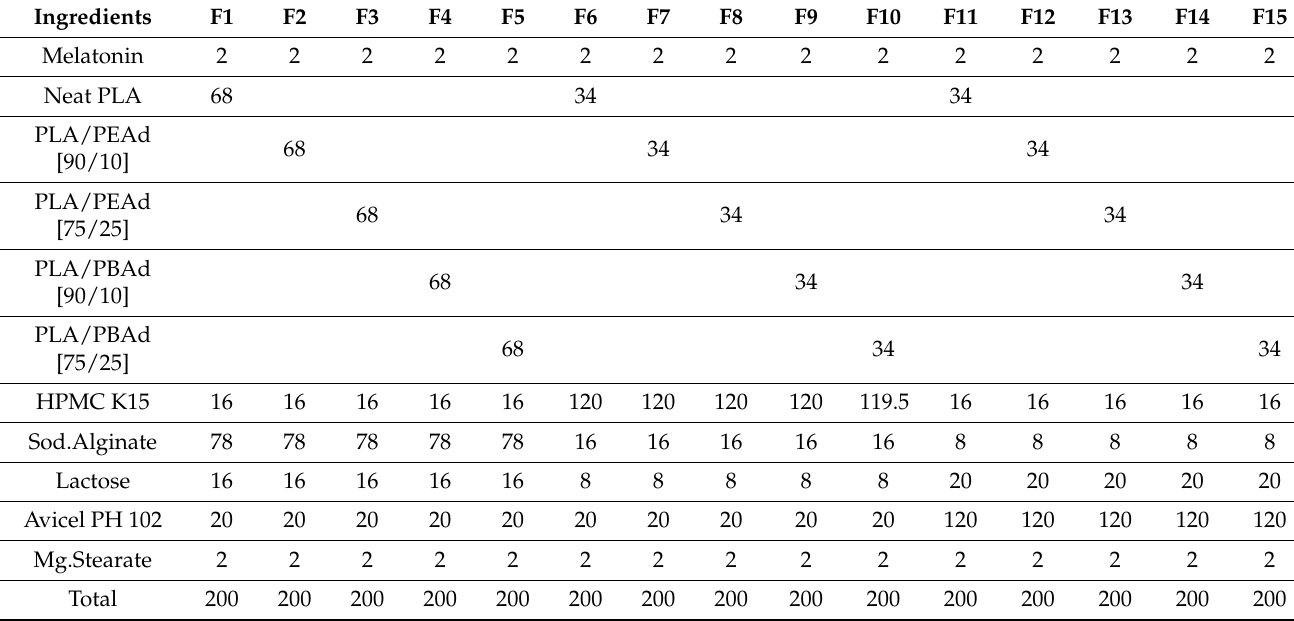
Table 1. Composition of melatonin tablet